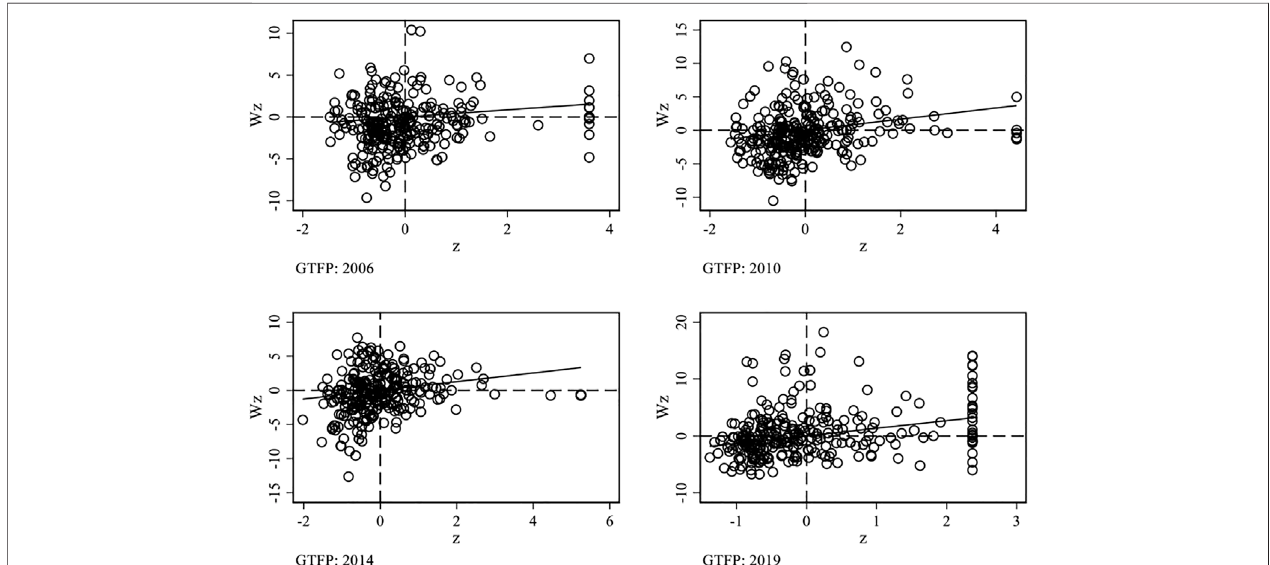
FIGURE 3 | Moran ’ s scatterplot of GTFP by city in 2006, 2010, 2014, and 2019.